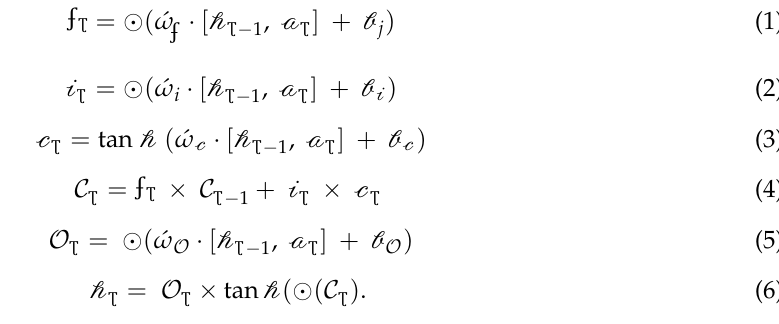
deployed a solo model that is insufficient to extract both types of features at a time. Therefore, in this work, we established a hybrid model that combines CNN with MB-GRU, as shown in Figure 1b. The proposed hybrid model includes an input layer, CNN layers, and bidirectional GRU layers. Two CNN layers are incorporated after several experiments over different layers and different parameters. Finally, we select filters of 8 and 4 for the first and second CNN layers with a kernel size of 3.1, respectively and used ReLU as an activation function in these layers. After convolutional layers, two bidirectional GRU layers are incorporated to learn the temporal information of the electricity historical data. Finally, the fully connected layers are integrated for the final output